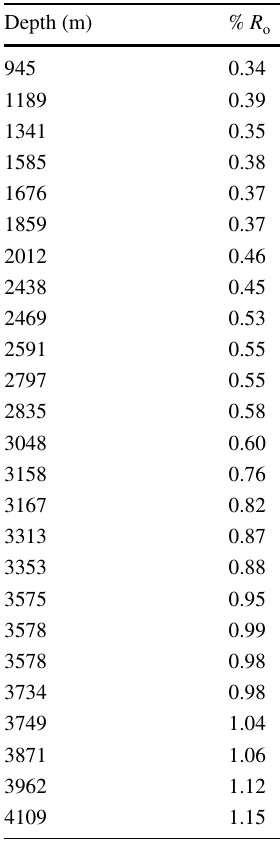
Table 2 Vitrinite reflectance values from Tara-1 well used in thermal maturity measure used in this study